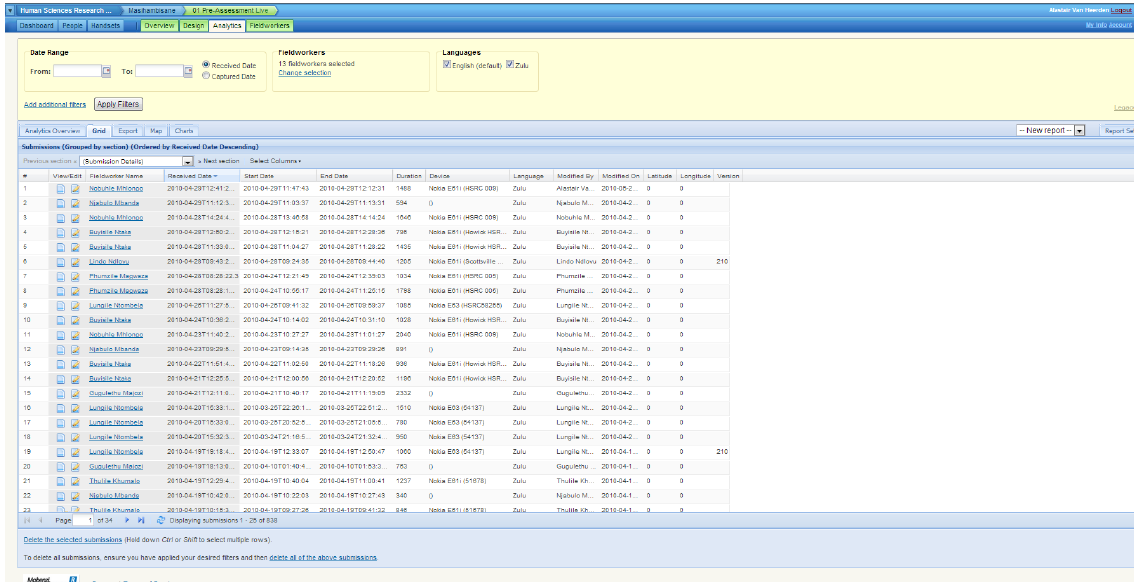
Figure 5. Example of Mobenzi Researcher Web portal: data overview and export.